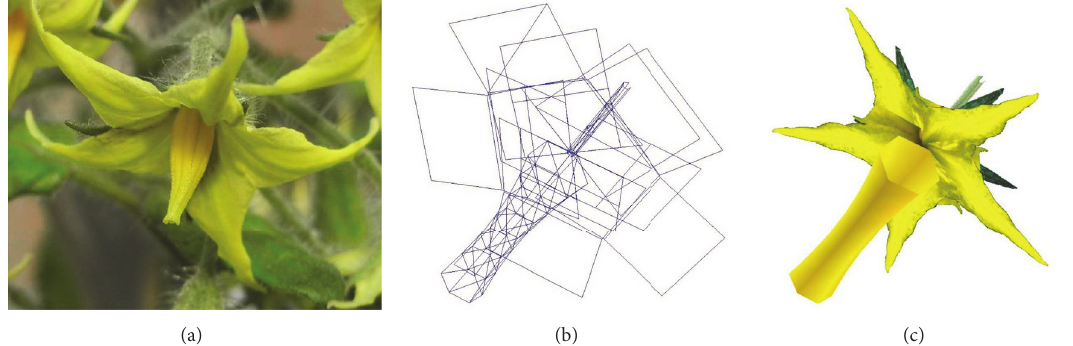
Figure 3: Modeling flowers with deformable meshes. (a) A tomato flower photo. (b) Each part of a virtual tomato flower is modeled with mesh. (c) A virtual tomato flower model.